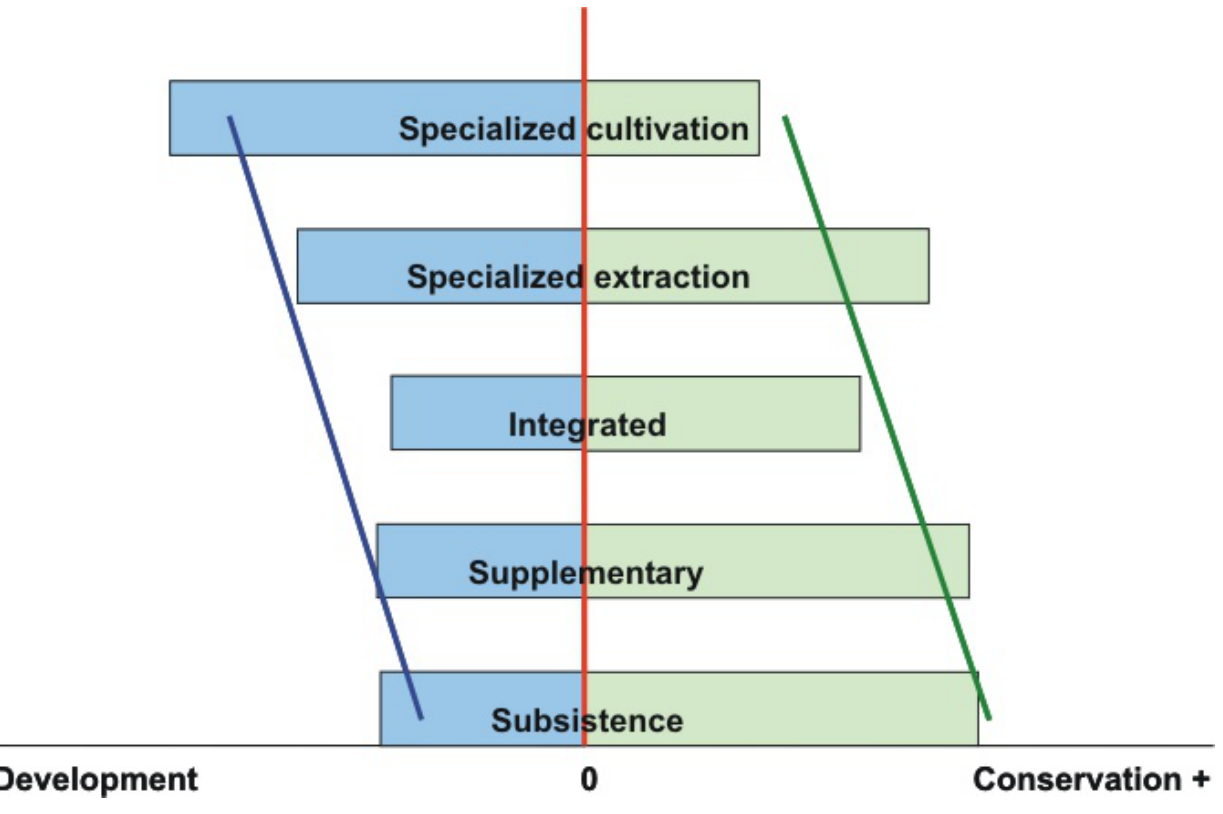
Fig. 6. The relation between household strategies, development, and conservation. The figure presents the relative relations, derived from mean